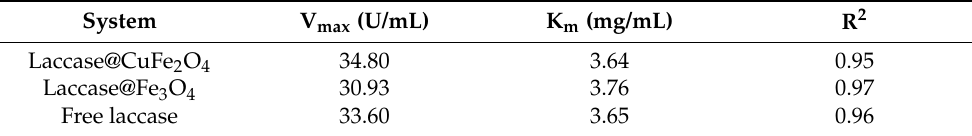
Table 1. Kinetic parameters for free laccase and nanoparticle-immobilized